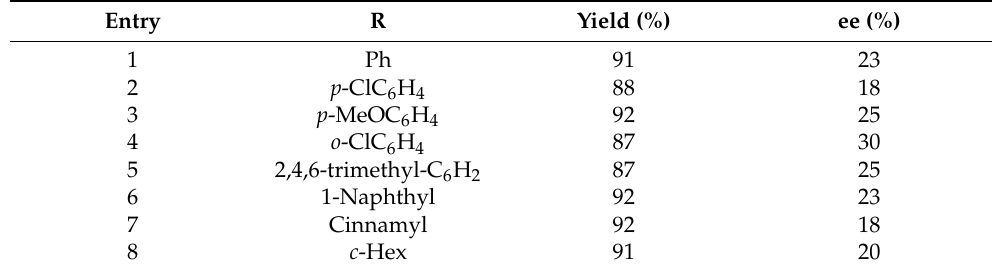
Table 6. Scope of Connon’s enantioselective synthesis of terminal aziridines (Scheme 25).